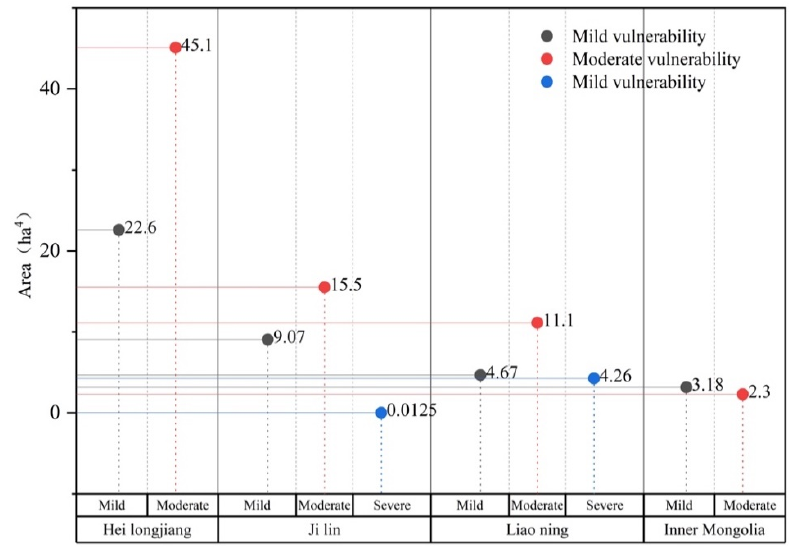
Figure 10. Statistics of cultivated land ecosystem vulnerability in Northeast China.